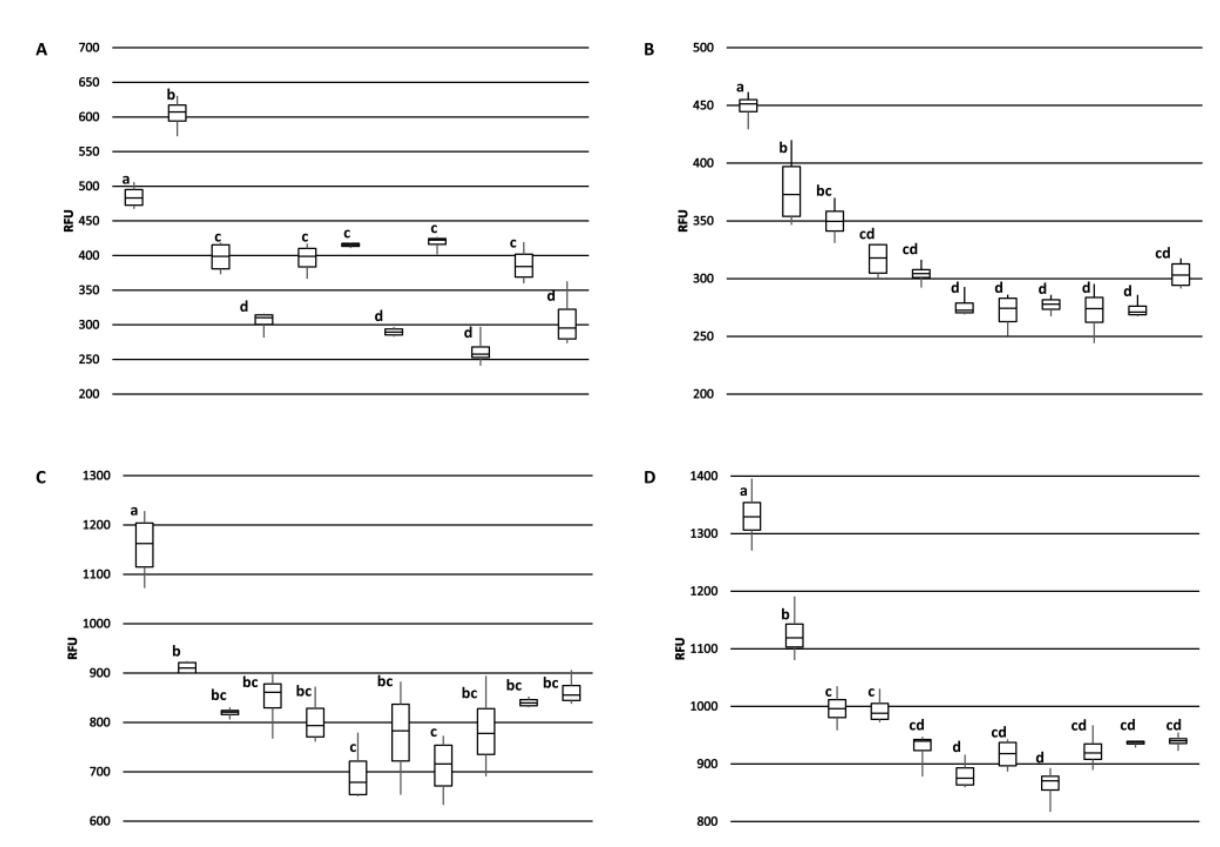
Figure 7. Comparison of Ana o 3 antibody binding among Brazilian cashew nut cultivars. Samples from left to right in each graph are; CCP1001, BRS189, BRS226, BRS265, BRS274, BRS275, CCP06, CCP09, CCP76, RMBRAPA50, and EMBRAPA51. Graphs represent ELISA values for ( A ) 2H5, ( B ) 5B7F8, ( C ) 6B9C1, and ( D ) 19C9A2 monoclonal antibodies. Relative fluorescence units (RFU) are indicated on the y -axis. Box plot of antibody binding with the median indicated and error bars included show minimum and maximum values. Statistical significance is indicated overhead each data point by lowercase letters independently for each panel.